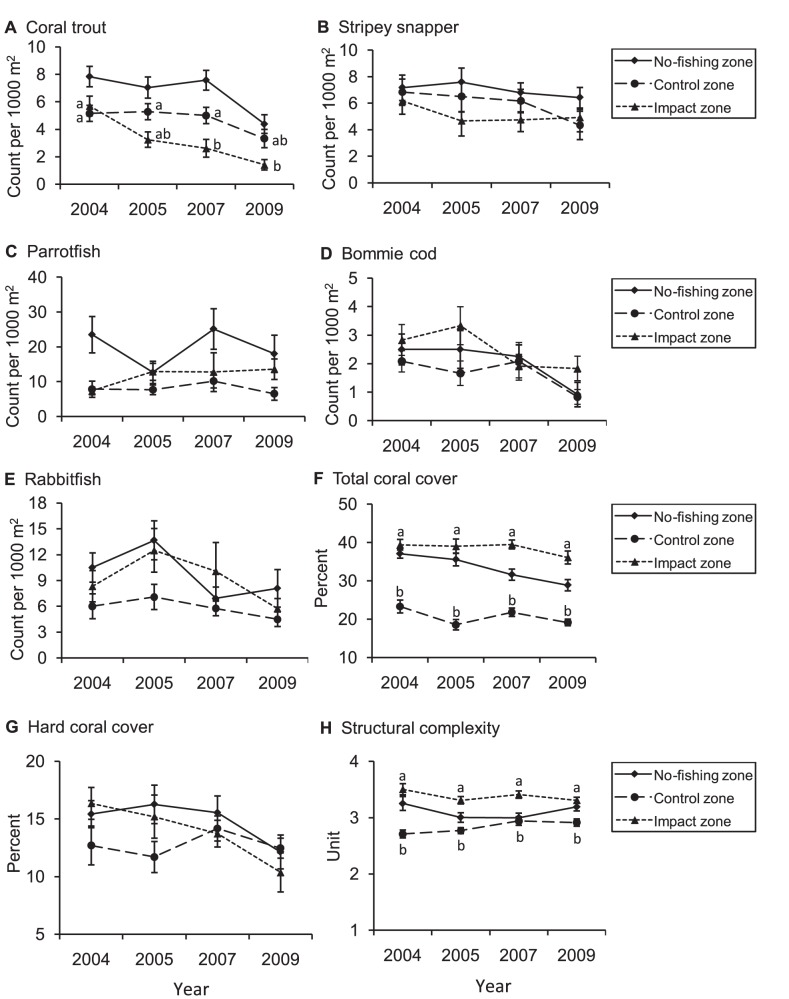
Mean fish density (A-E), coral cover (F, G) and structural complexity (H) (±1SE) from 2004 to 2009.Data for the no-fishing zone are shown only for the purpose of comparison. The management history of each zone is described in Figure 2. Structural complexity was defined on a scale of zero to five (see text for definitions). Means were calculated from 40 samples (underwater visual transects) per zone per year. Groups with the same letters were not significantly different.